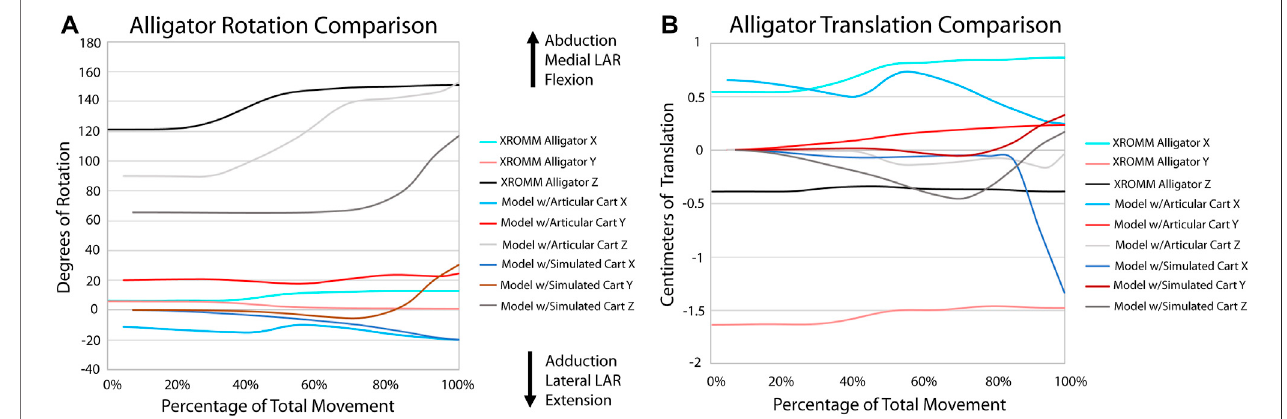
FIGURE 5 | Comparison of kinematic data of the alligator simulations and XROMM analysis. (A) Comparison of rotational data. (B) Comparison of translational data.